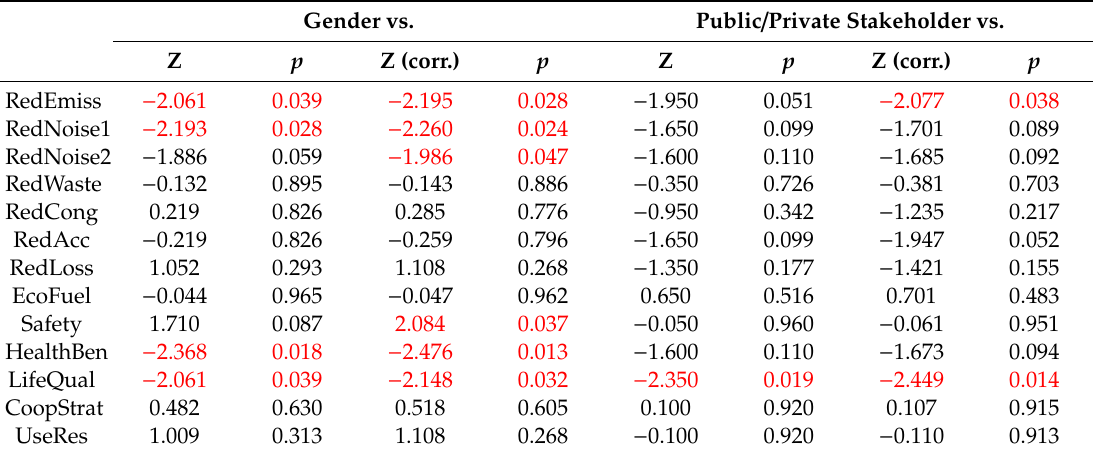
* the color red in the table signifies statistically important results with <